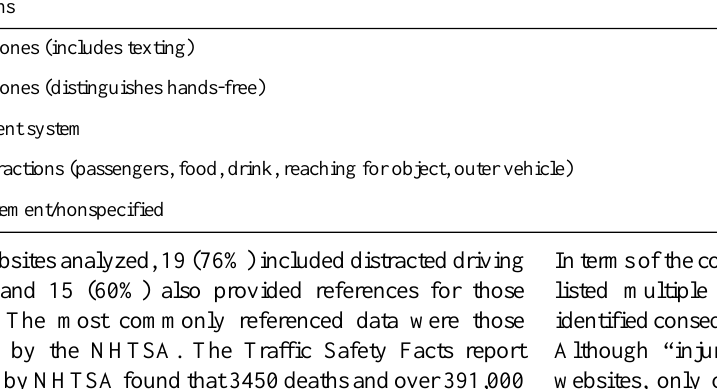
Websites describing distraction, n (%)Distractions